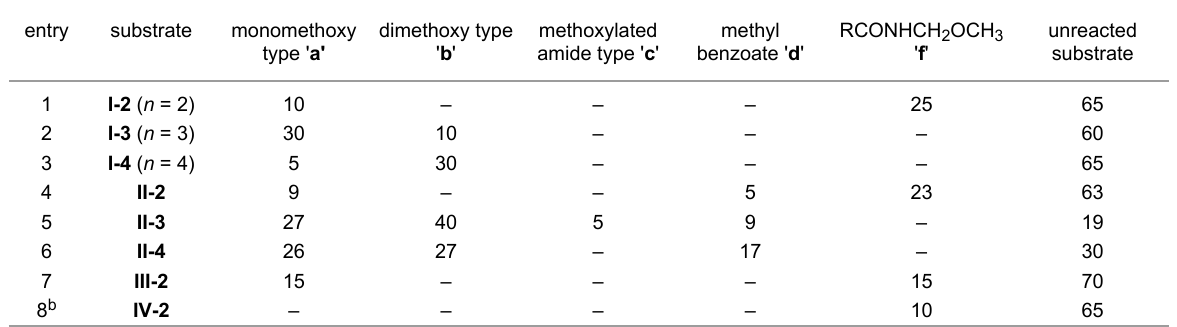
Table 3: Results of anodic oxidation of all substrates on a C rod anode in MeOH/LiClO 4 . (10 F/mol; 20 mA/cm 2 ) a .